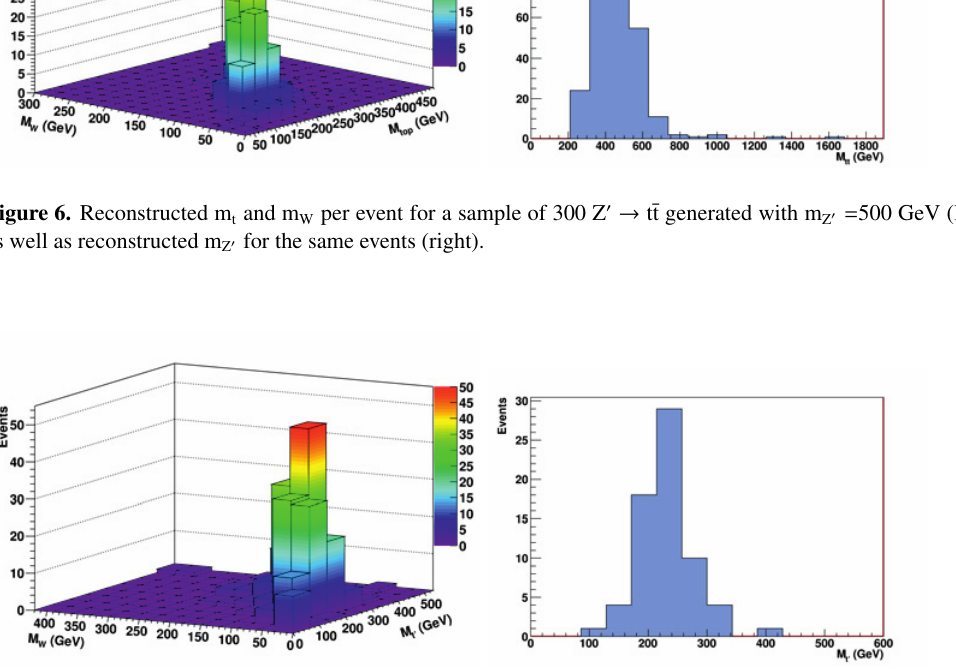
Figure 7. Reconstructed m t (cid:3) and m W per event for a sample of 300 t (cid:3) ¯t (cid:3) → W + bW − ¯b → l + l − b¯b ν l ¯ ν l events gen- erated with m t (cid:3) = 250 GeV (left) as well as reconstructed m t (cid:3) when requiring m W to be in the range 70-90 GeV